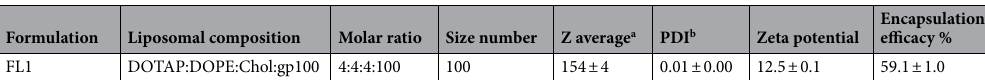
Table 2. The physicochemical properties of liposomal formulation and percentage of encapsulation efficacy. (mean ± SD; n =